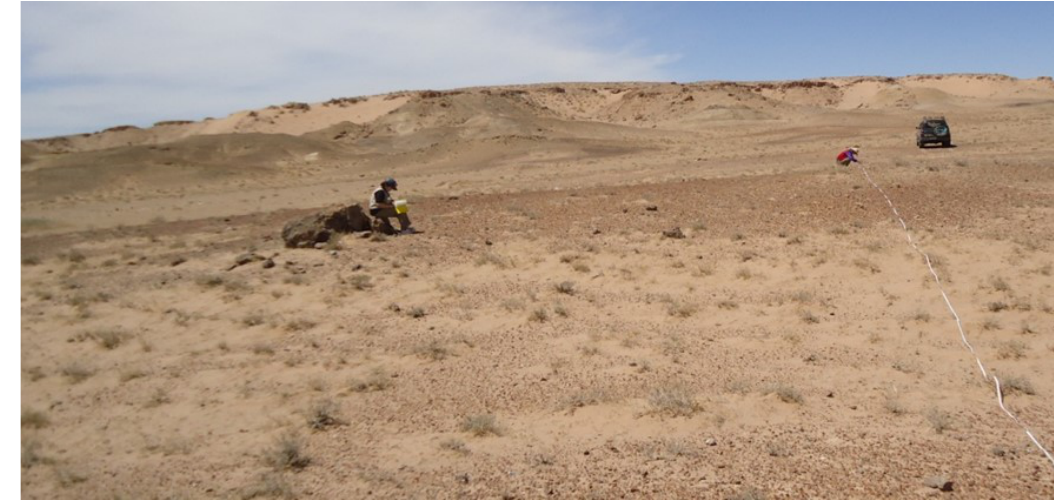
Fig. 4. View on sediments outcrop of the Lower: Clay-siltstone package